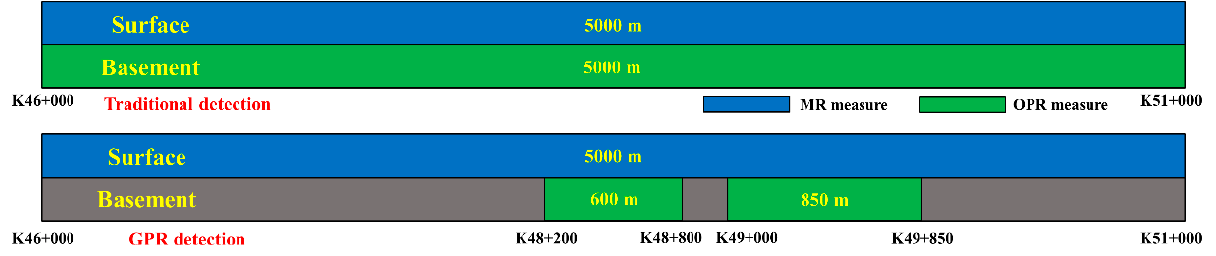
Table 9. The average cost and economic effectiveness of the two maintenance